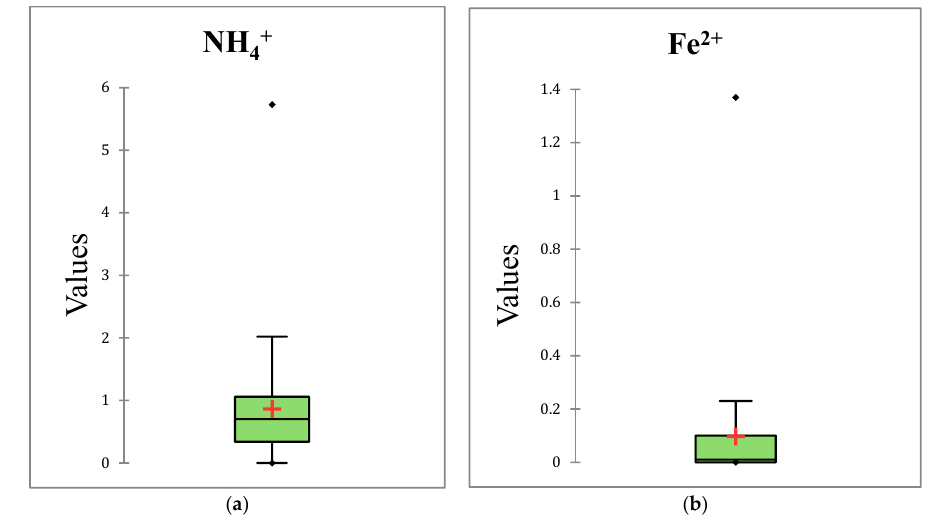
+ variation. ( b ) Fe 2 + Figure 7. a) NH 4+ variation. b ) Fe 2+ variation. Figure 7. ( a ) NH 4